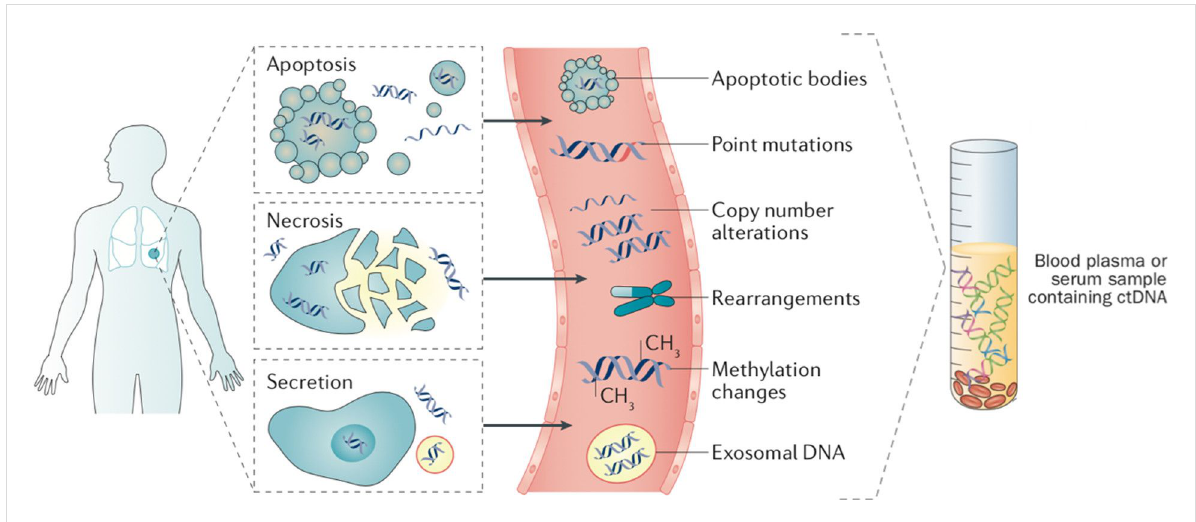
Figure 1: Alterations in cell-free DNA. Cell-free DNA can be released from both cancerous and normal cells located in the tumor environment through apoptosis, necrosis or secretion. Once in the bloodstream, cfDNA may exist either free or associated with extracellular entities such as exosomes. cfDNA can carry multiple classes of tumor-derived genetic alterations including point mutations, copy-number fluctuations and structural rearrange- ments. Reprinted with permission from [45], copyright 2017 Springer Nature.